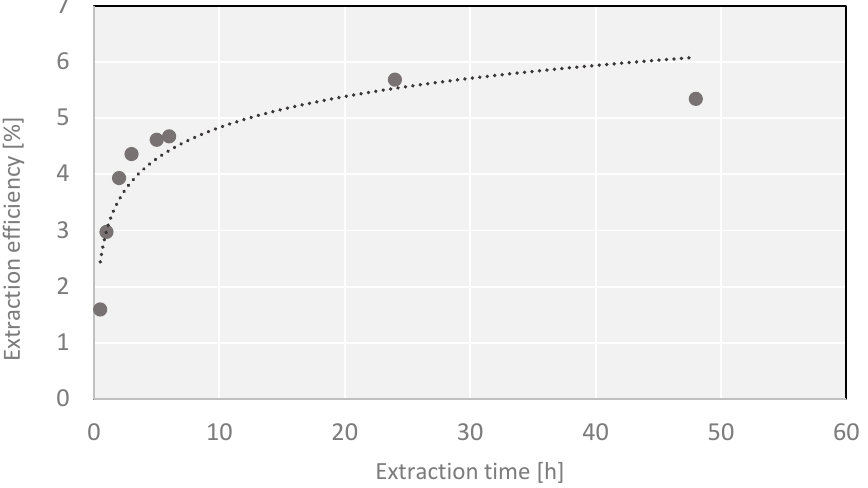
Figure 3. Dependence of the yield on the extraction time in an ultrasonic bath and Soxhlet apparatus.